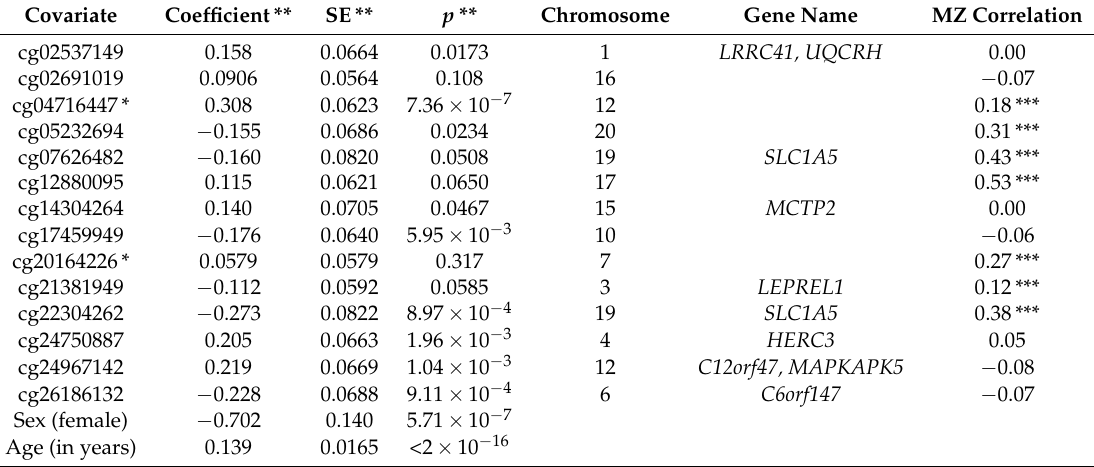
Table 4. The variables chosen by the least absolute shrinkage and selection operator (LASSO) for the mortality predictor. The second column gives the coefficients for the linear predictor. All methylation values are normalized to have a standard deviation of